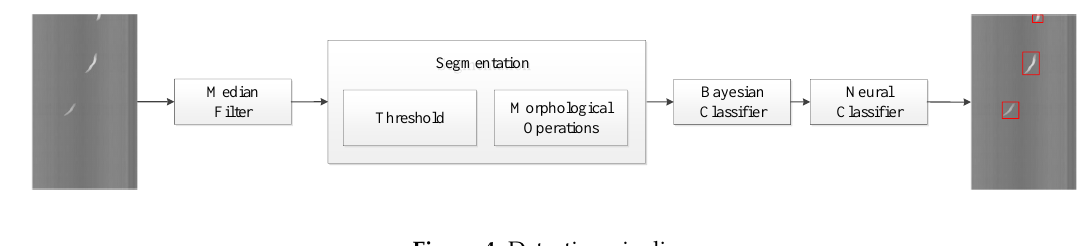
Figure 4. Detection